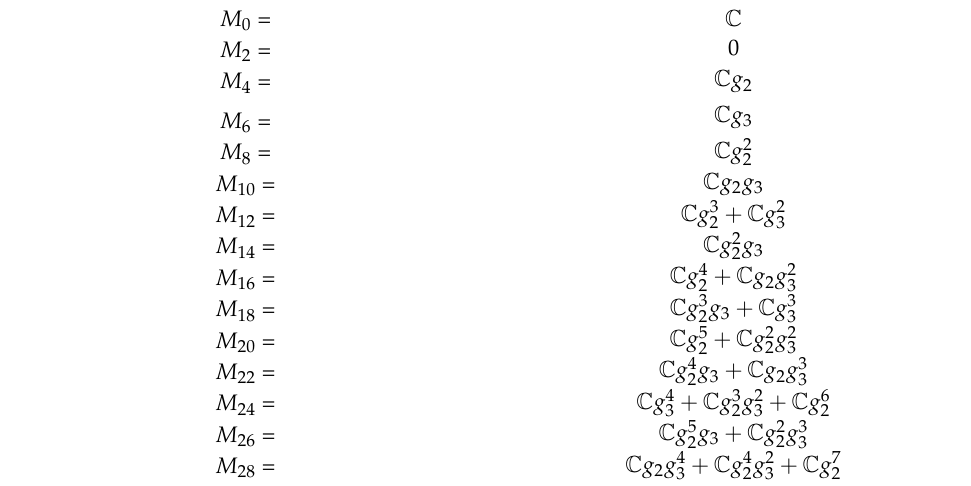
Table 1. Table of M 2 n for n ≤